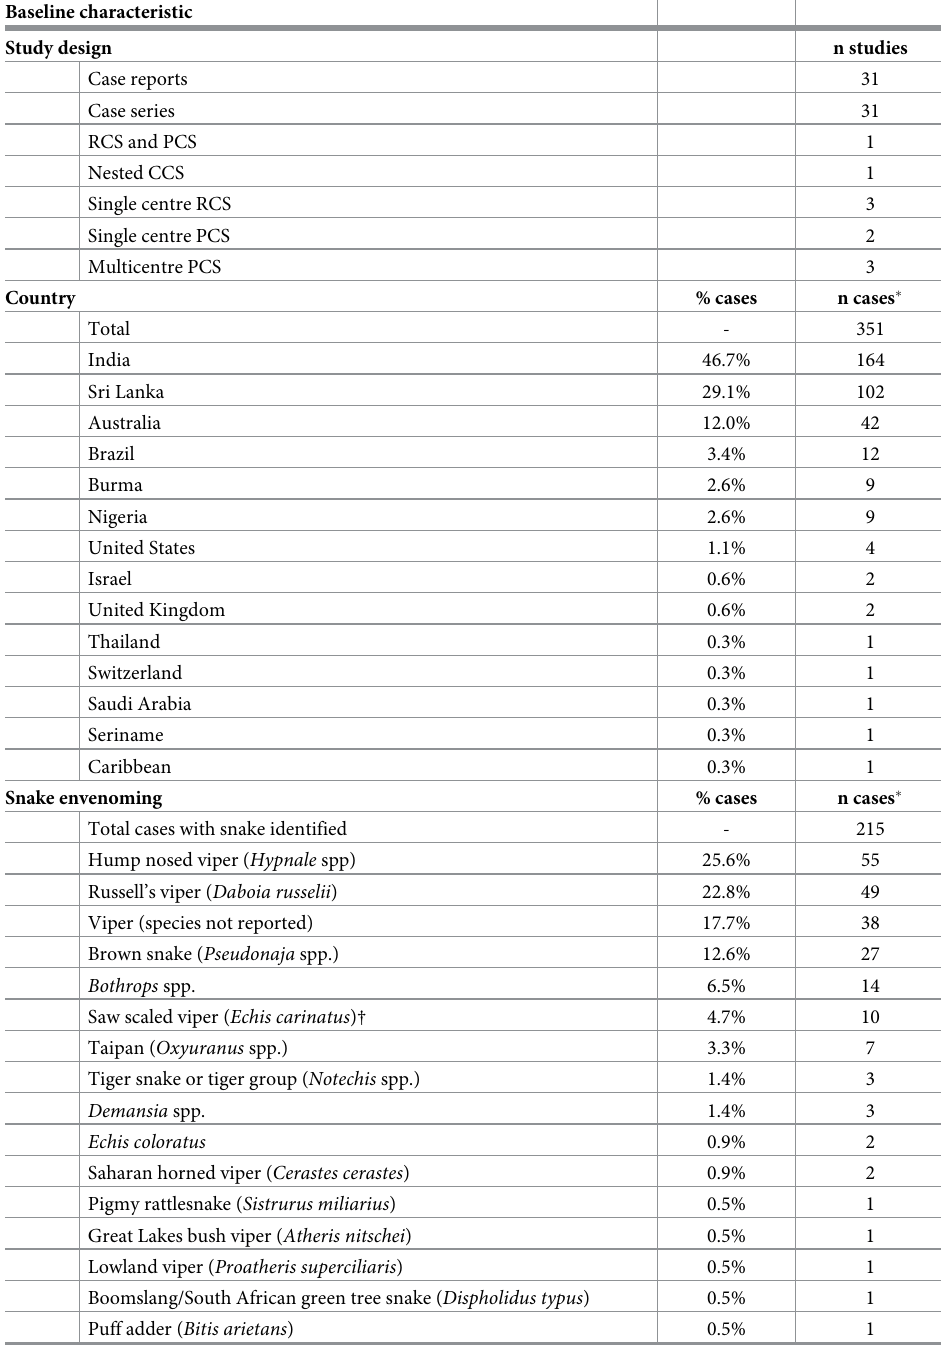
Table 1. Characteristics of included